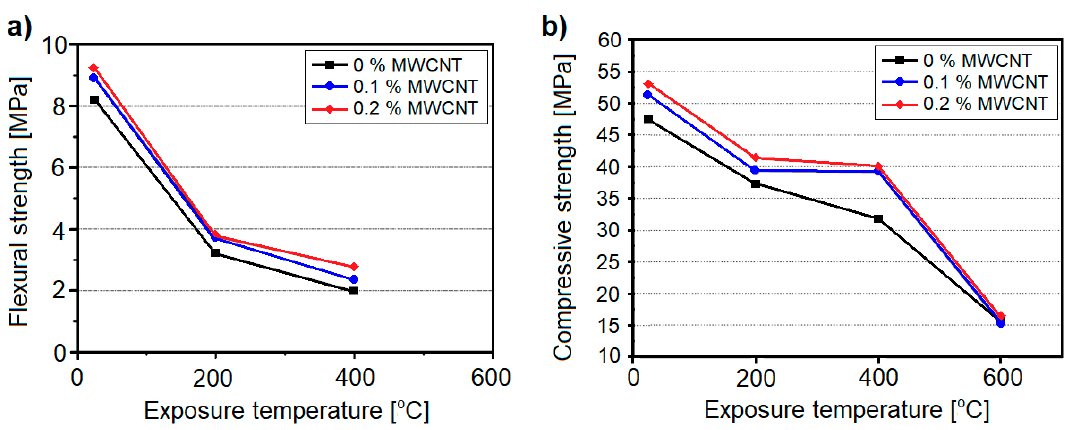
Figure 8. The effect of hydroxylated Multi-Walled Carbon Nanotubes (MWCNTs) on the flexural ( a ) and compressive ( b ) strengths of cement pastes exposed to elevated temperatures. Reproduced with permission from [63]. Copyright Elsevier, 2017.